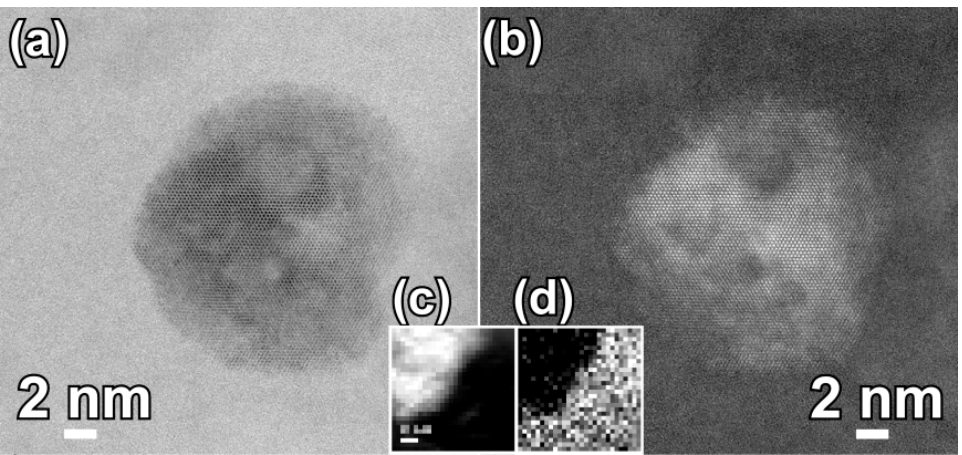
Figure 3. High-resolution bright field transmission electron microscope (TEM) image ( a ) and high angular dark field TEM image ( b ) of Fe 85.2 B 10 P 4 Cu 0.8 alloy after annealing at 680 K for 600 s. EELS image ( c ) and distribution of B element ( d ) at the interface of α -Fe grain and residual amorphous matrix.